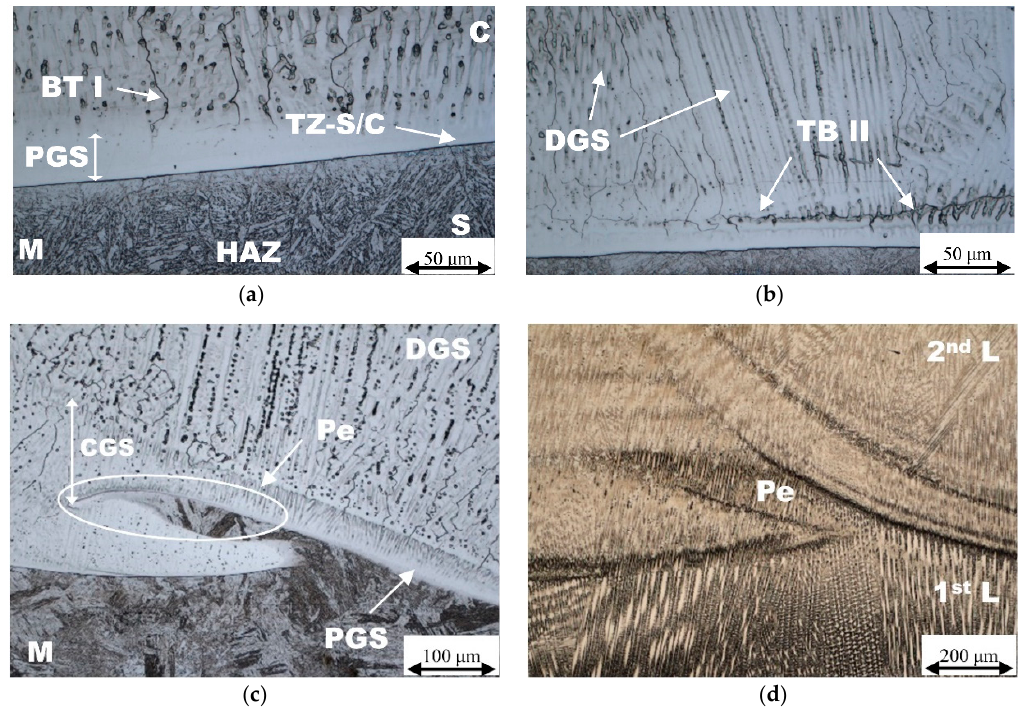
Figure 2. Optical micrographs of the transition zone of substrate/clad (TZ-S/C): ( a ) clad (C), grains with boundary type I (BT I), martensite (M) in the heat affected zone (HAZ) of the substrate with coarse grains, and planar growth solidification (PGS); ( b ) grains with boundary type II (BT II) and dendritic growth solidification (DGS); ( c ) heat affected zone with martensite (M), peninsula-like macrosegregation (Pe), large and small solidification regions with cellular and planar growth solidification (CGS and PGS, respectively); ( d ) peninsula-like macrosegregation (Pe) between the first and second layers (1st L and 2nd L, respectively) of clad II.